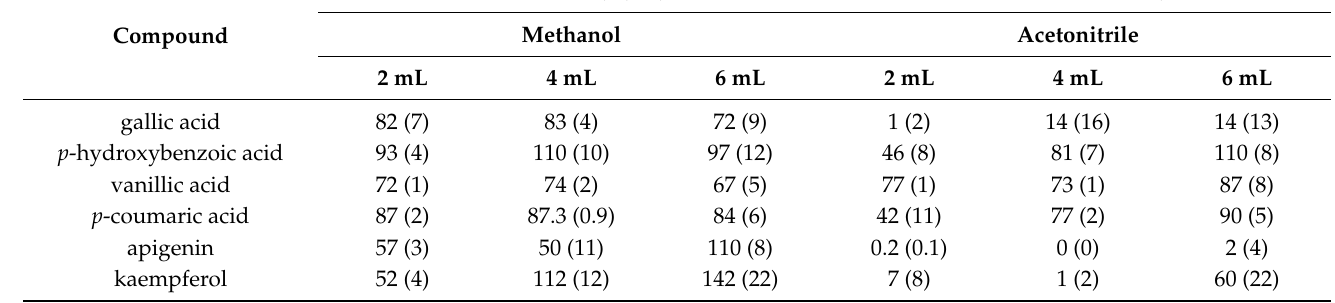
Table 2. Off-line SPE recovery values for 6 selected polyphenolic compounds when employing different elution solvents and